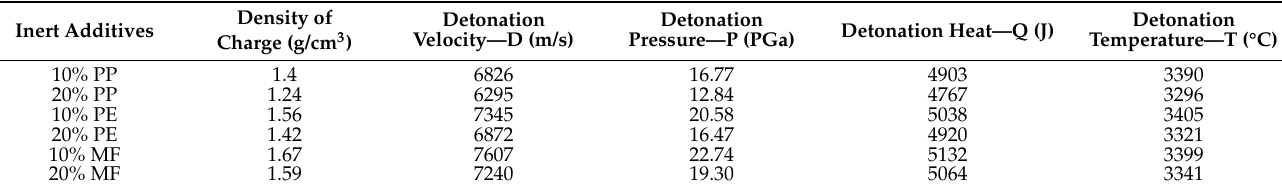
Table 3. Calculation results of detonation parameters of the